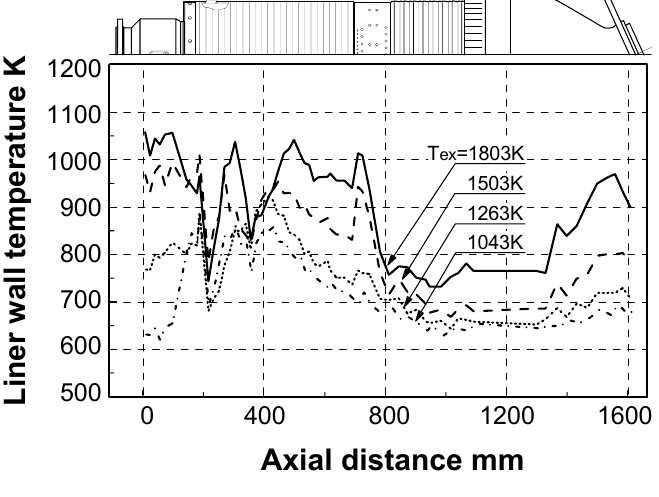
Figure 63. Influence of combustor exhaust temperature on combustor wall temperature